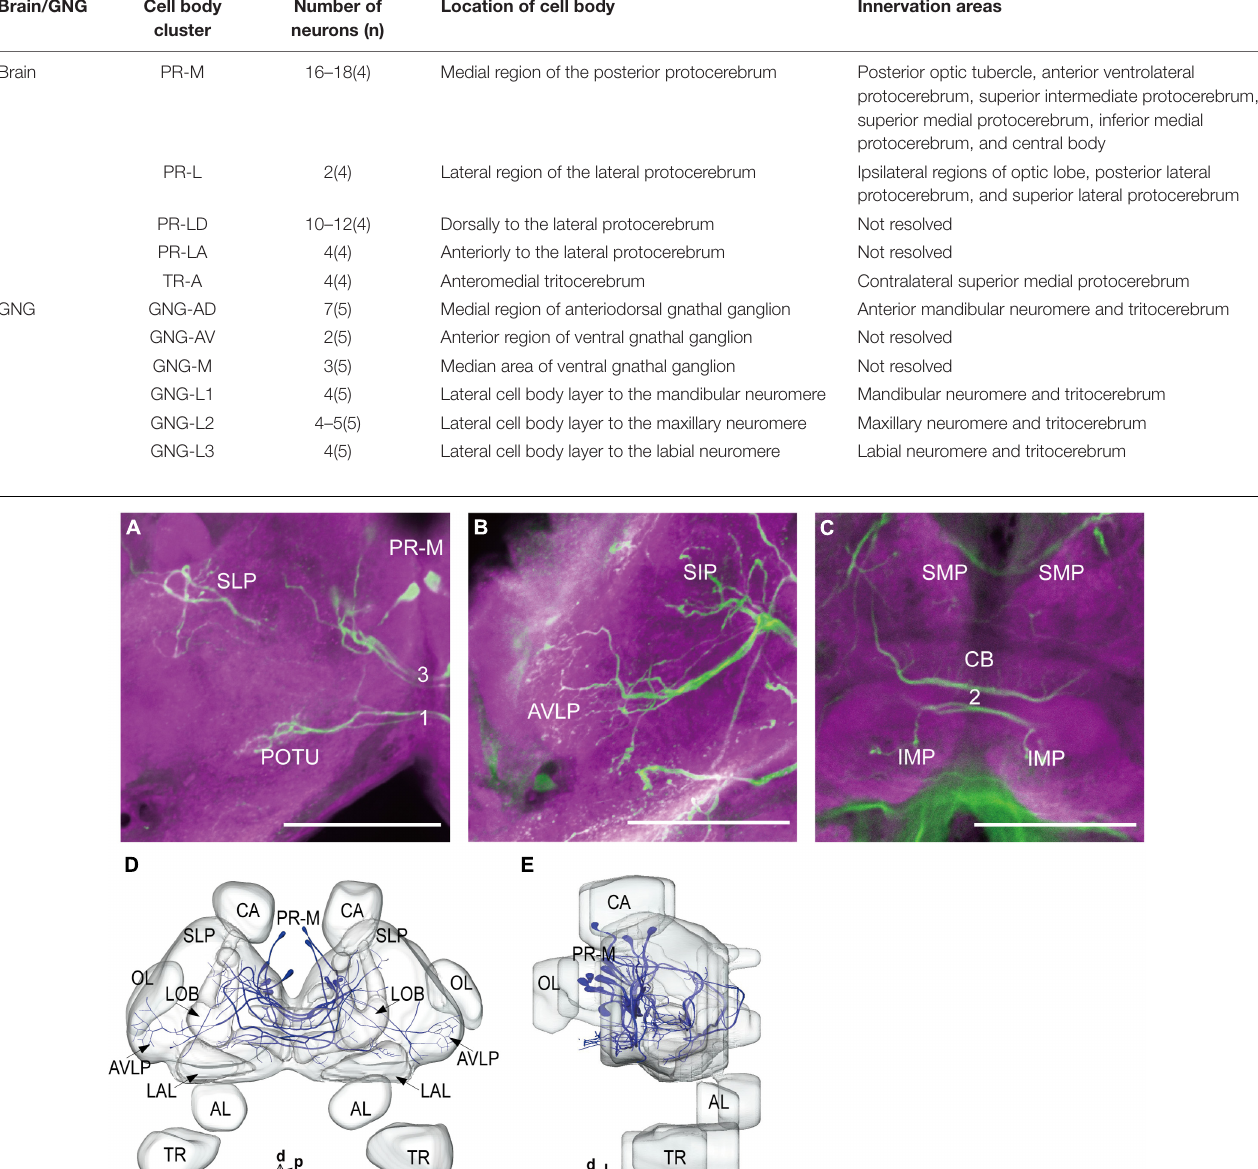
TABLE 1 | Number, location, and innervation areas of serotonin-immunoreactive neurons in the brain and the gnathal ganglion of Spodoptera frugiperda larvae. Brain/GNG